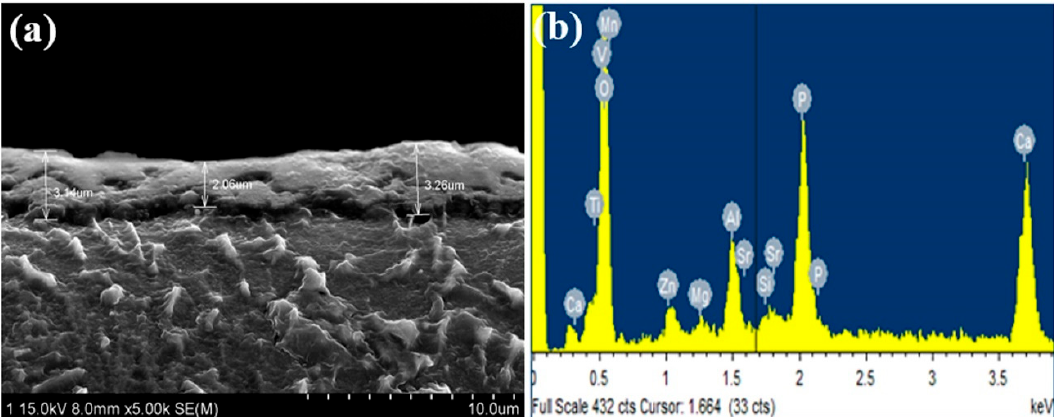
Figure 3. Atomic force microscopy (AFM) results of the implants: ( a ) Ti64/SA implants and ( b ) Ti64/7 ion implants.